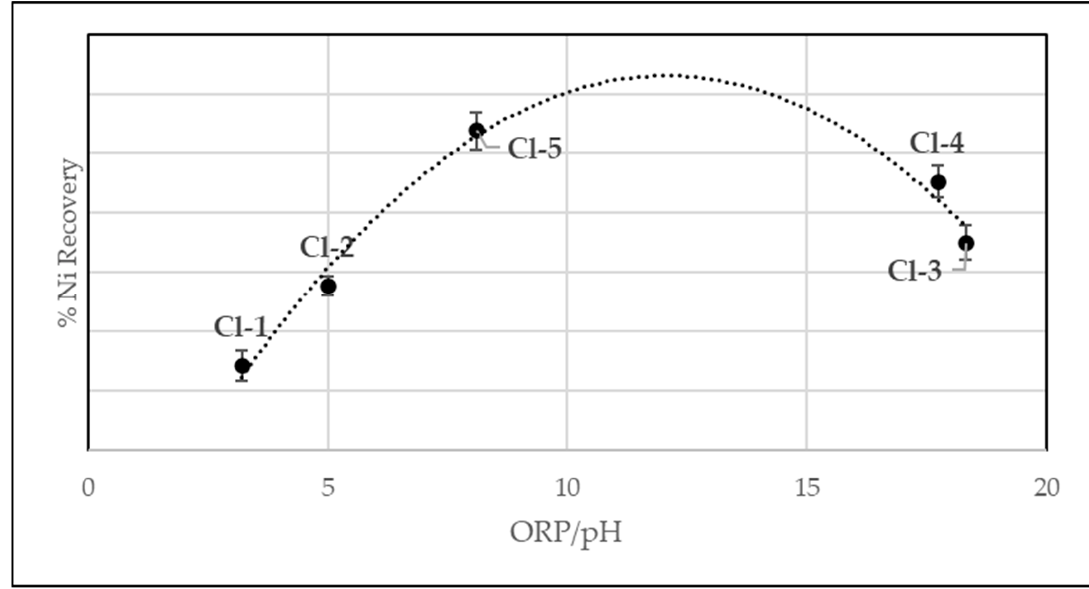
Figure 8. Effect of ORP/pH of nickel flotation feed on recovery of pentlandite.